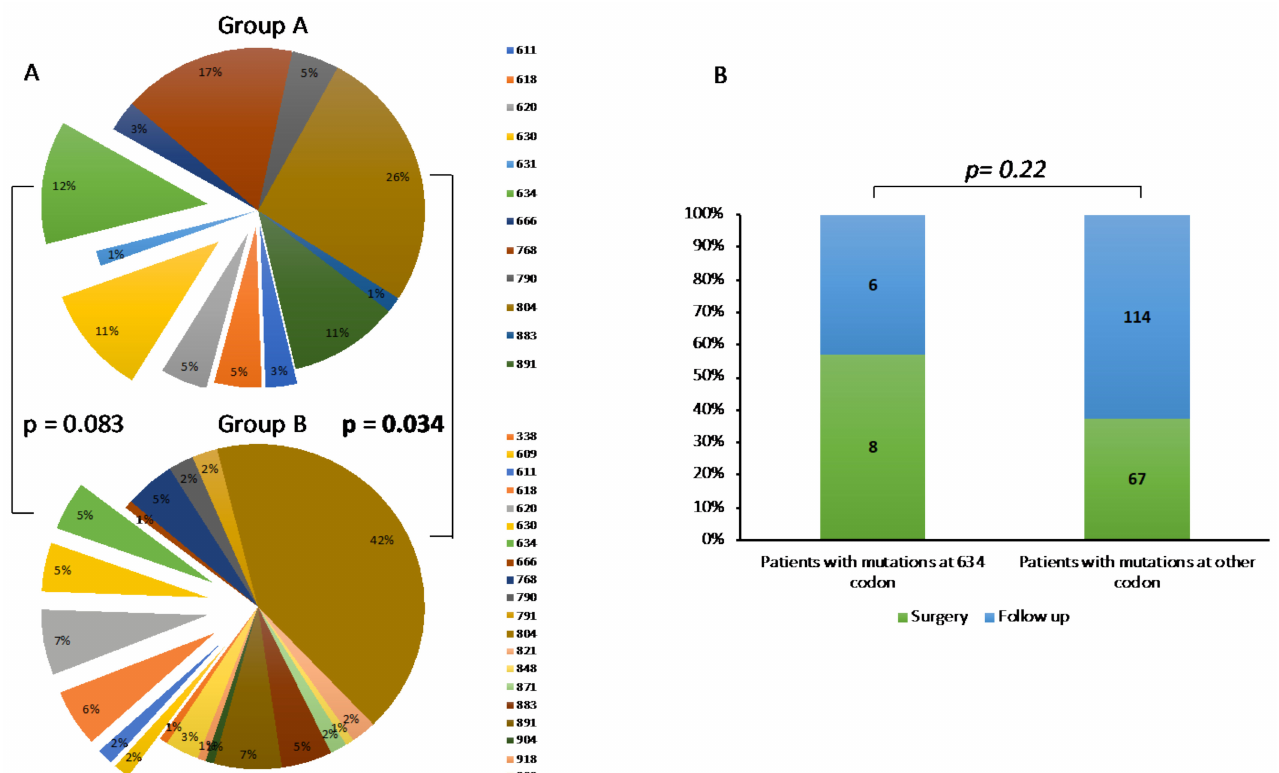
Figure 1. ( A ) Genetic landscape of Group A (upper graph) and B (lower graph). ( B ) Rate of patients submitted to surgery or follow-up, according to RET mutations (634 codon vs. other